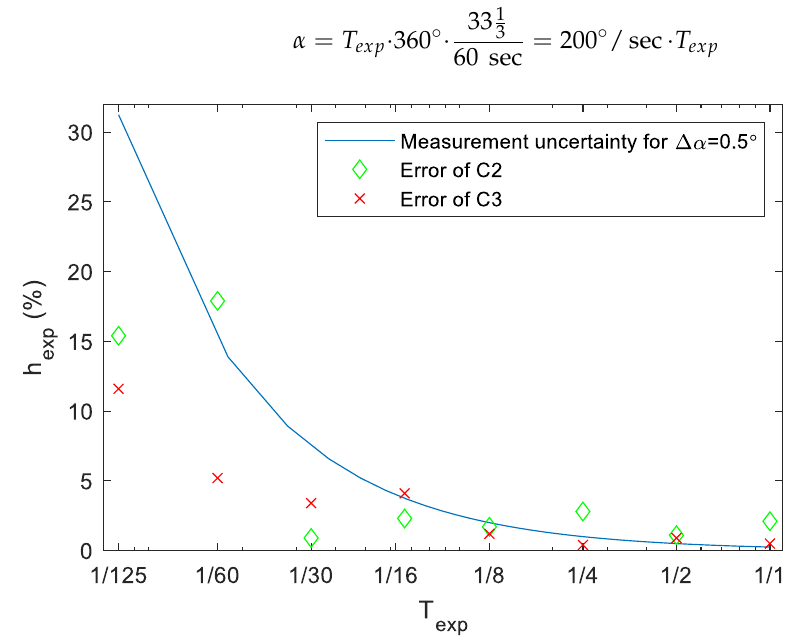
Figure 9. Relative measurement uncertainty of the turntable measurement.